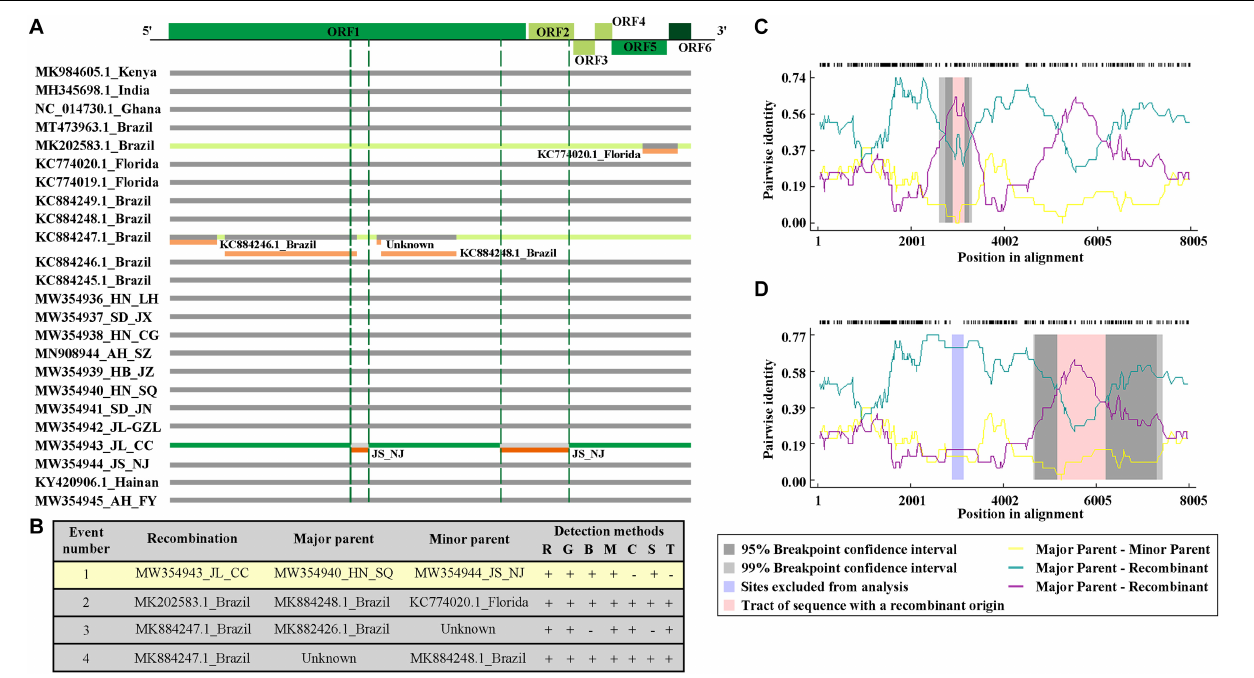
FIGURE 4 | Recombination events among the CPMMV isolates. (A) Schematic representation of the recombination events identified among CPMMV isolates by the RDP 5 program. Each box represents a viral isolate with the recombination events identified by different color (green and orange). The CPMMV genome is shown at the top of the figure. (B) Details of recombination events in the complete coding sequence of CPMMV isolates. Recombination detection methods are represented by letters: R, RDP; G, Genecov; B, Bootscan; M, Maximum v2; C, Chimera; S, Sister scan; 3, 3 Seq. (C,D) Evidence of recombination event in the isolate JL_SMV1.